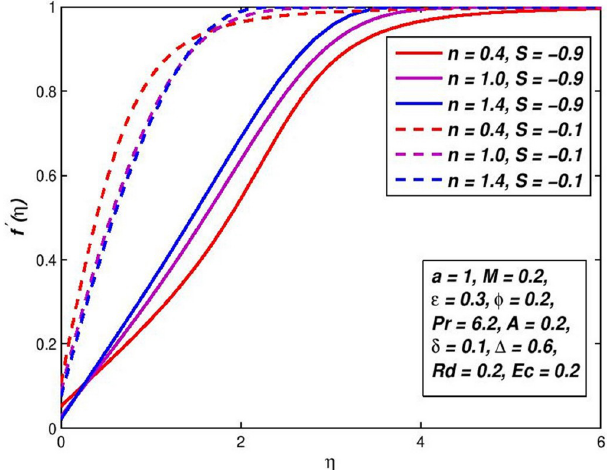
Fig 16. Effect of S < 0 on f 0 ( η ) for diverse n